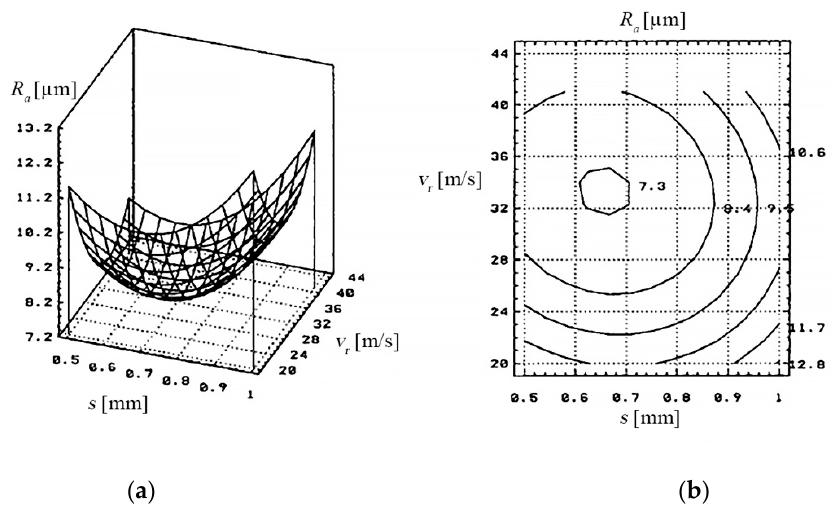
Figure 19. The dependency of the arithmetical mean deviation of the assessed profile ( R a ) to the thickness ( s ) of the metal band and the relative speed ( v r ) of the electrode-tool; ( a ) 3D graph, ( b ) 2D graph.